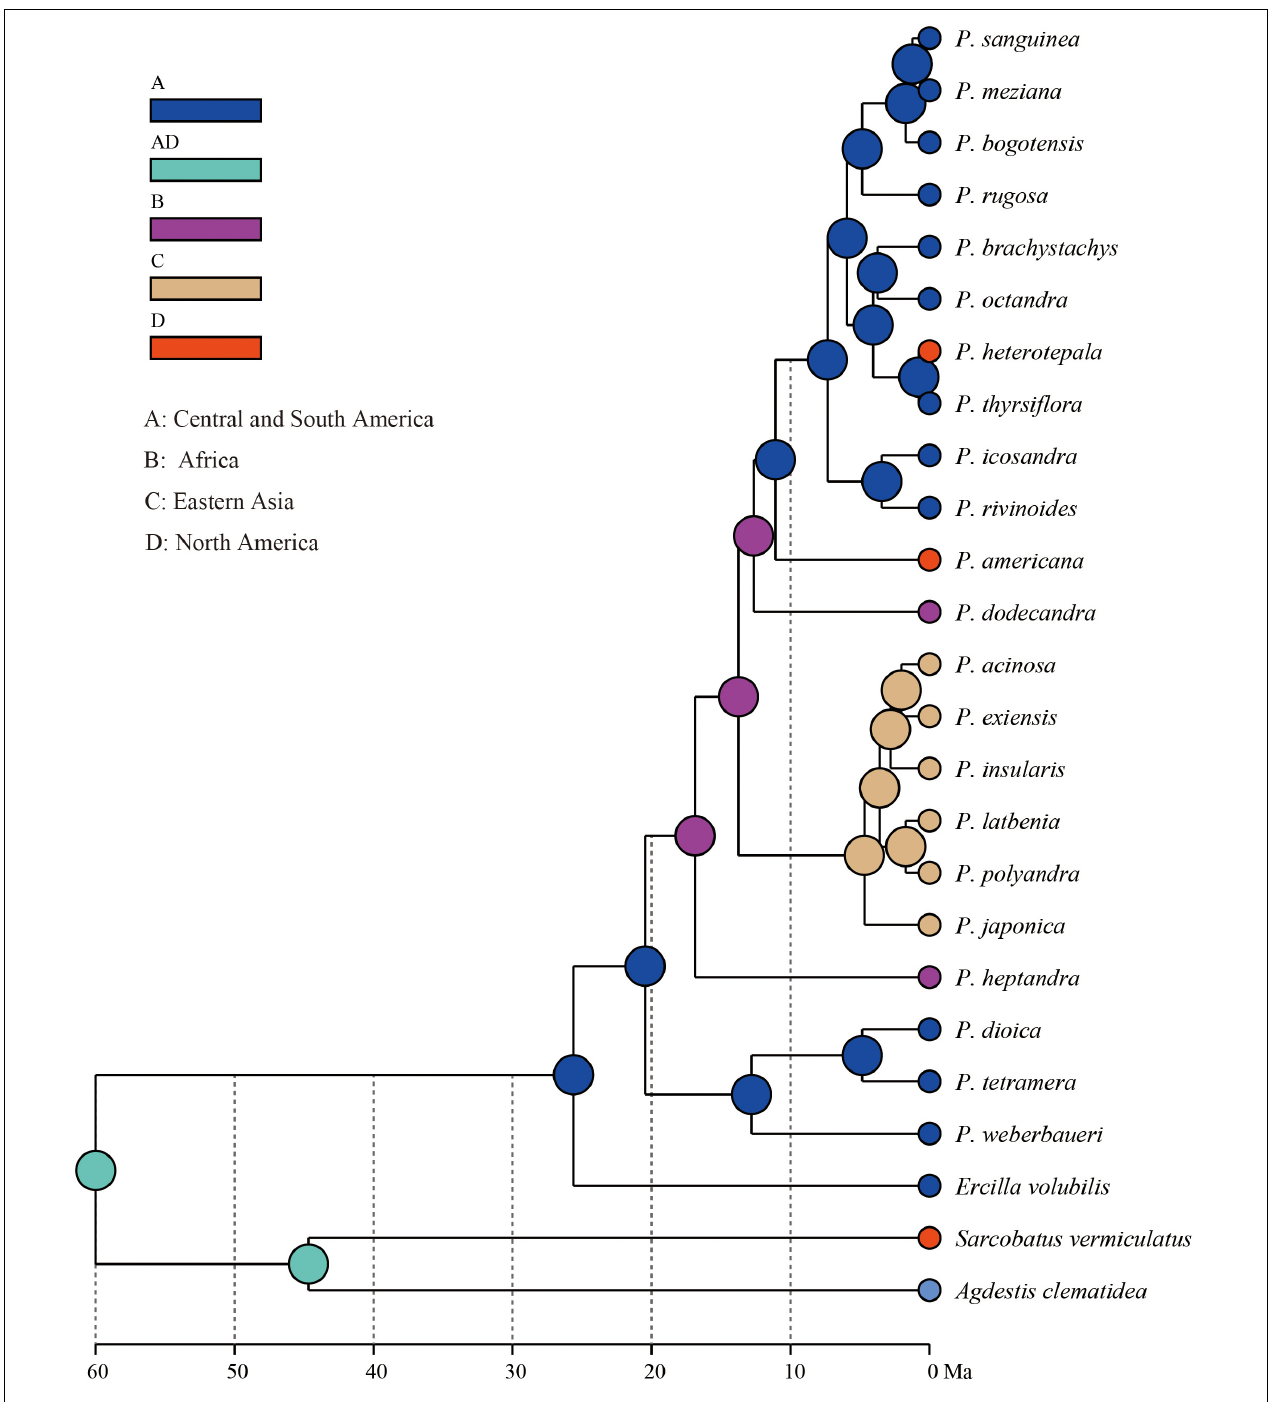
FIGURE 5 | Ancestral area reconstructions within Phytolacca using the 3g22s